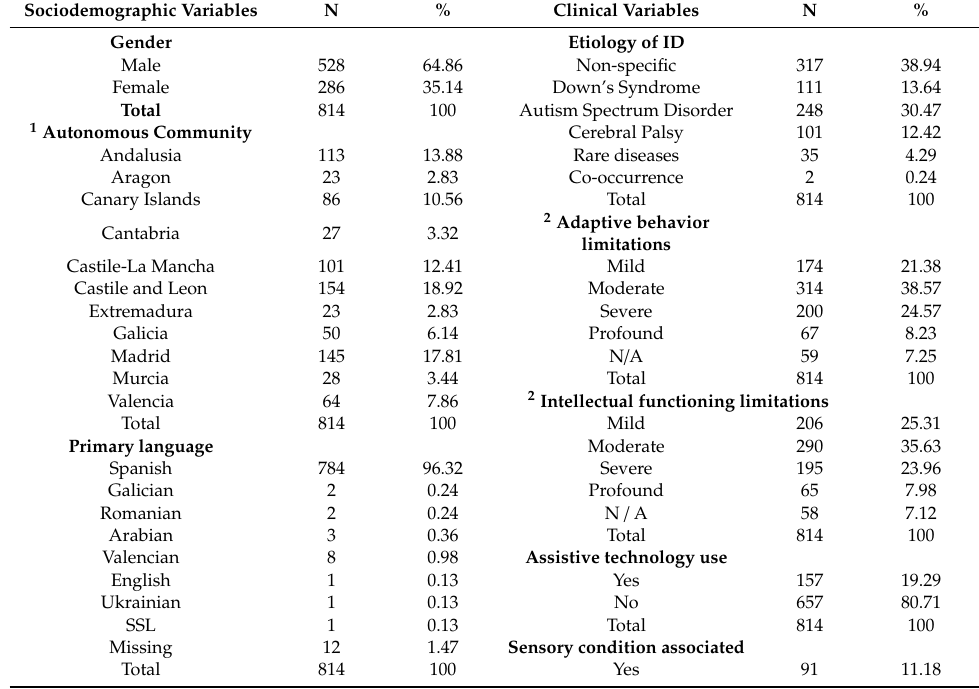
Table 2. Sociodemographic and clinical variables of the assessed children and